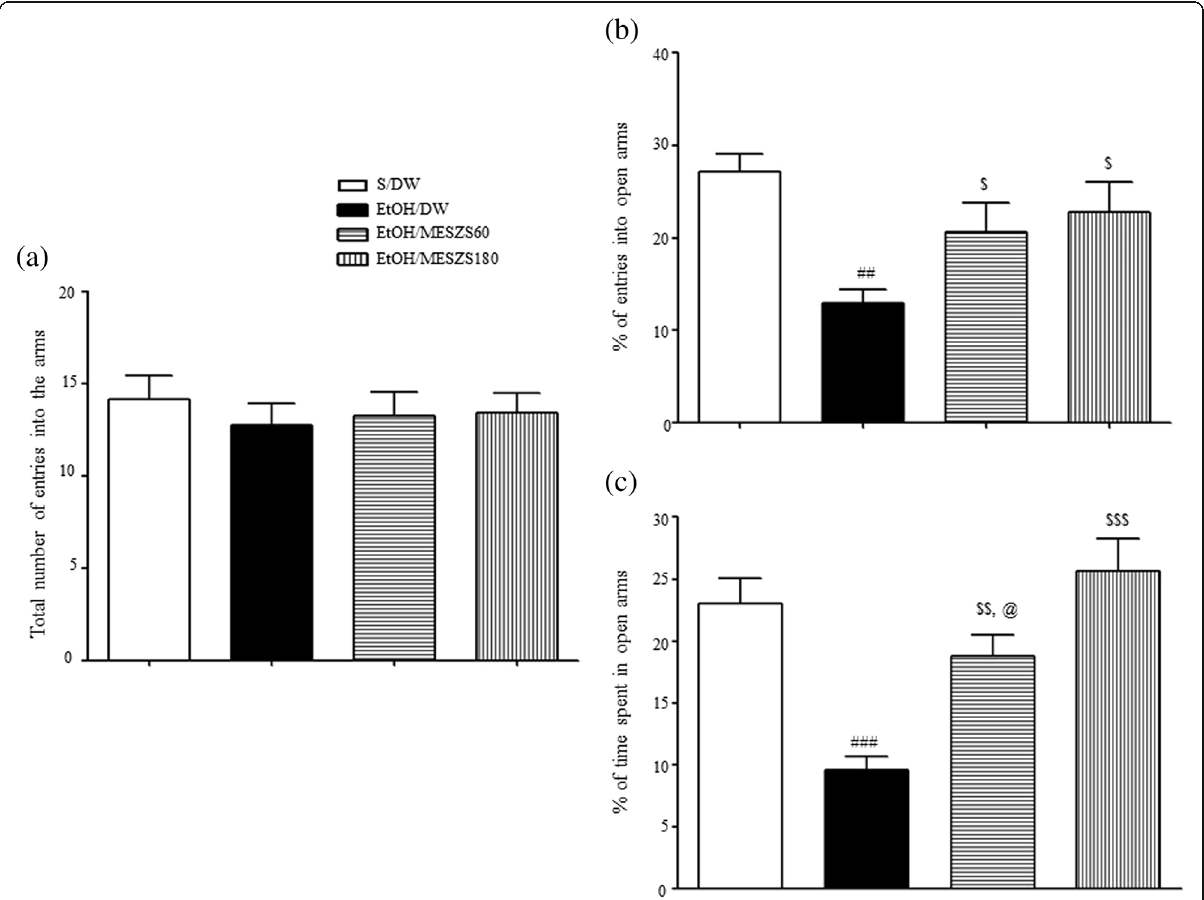
Fig. 3 Effects of MESZS on the behavioral changes of rats in the elevated plus maze test. All data are expressed as a mean ± SEM ( n = 8). ( a ) The total number of entries into (open and closed) arms of EPM by rats. ( b ) Percentage of numbers of entries into open arms. ( c ) Percentage of time spent in open arms. S: saline, DW: distilled water, MESZS: methanol extract of Semen Ziziphi Spinosae , MESZS60: 60 mg/kg/d MESZS,